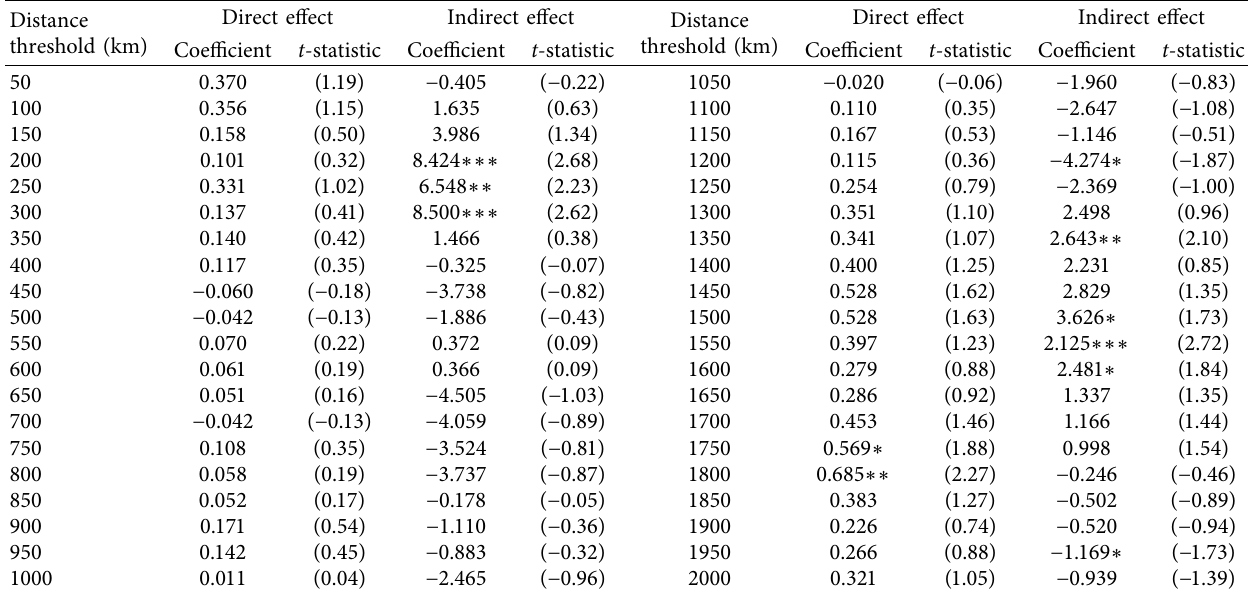
Table 11: Spatial spillover distance of the impact of the eastern region’s digital economy on urban